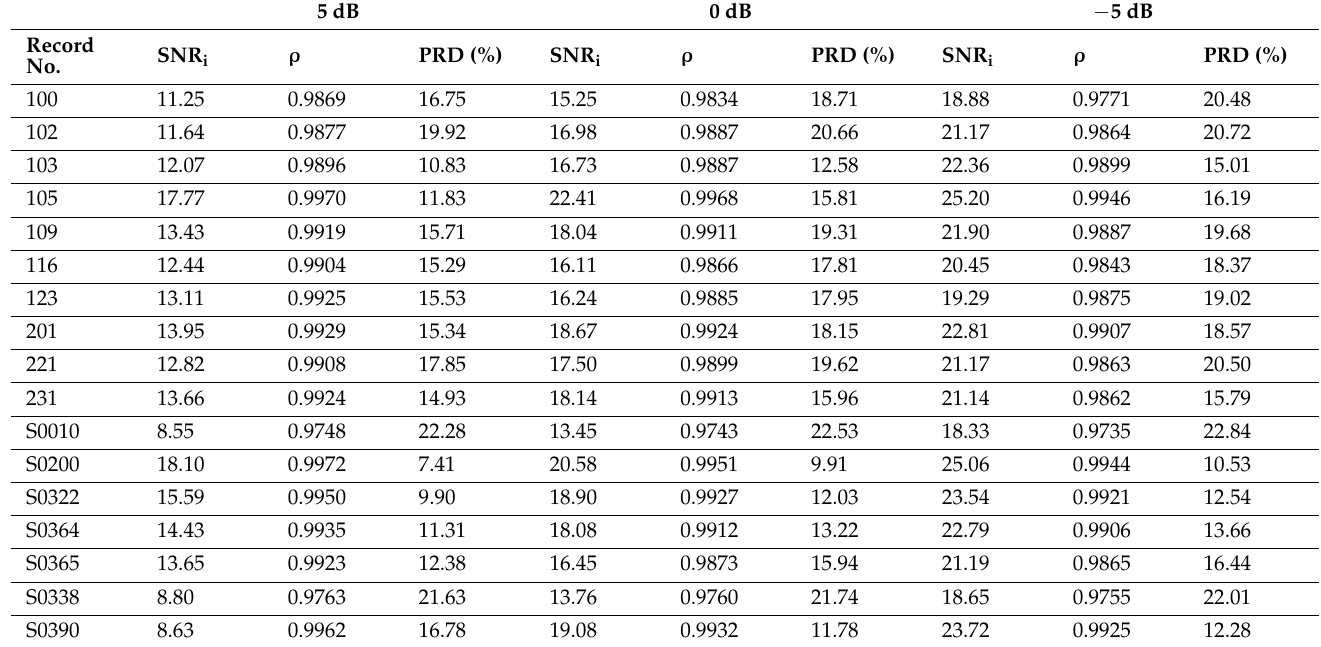
Table 4. Improvement in SNR, cross-correlation and PRD values between the denoised signal and the clean input signal in presence of 50 Hz PLI at various input SNR value.